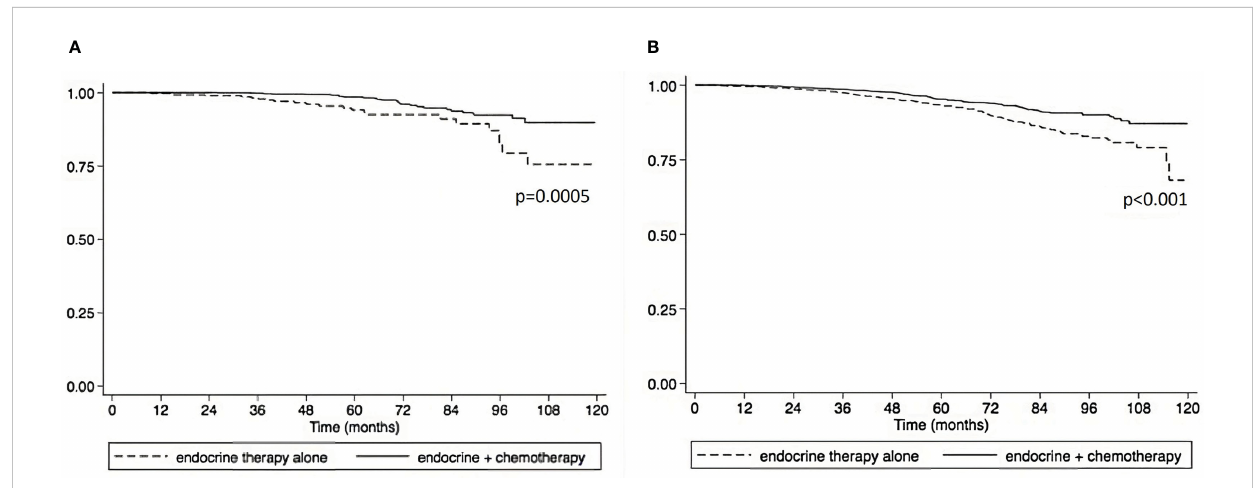
FIGURE 3 Overall survival compared between endocrine therapy alone versus endocrine therapy plus chemotherapy in pathological stage I-III HR+HER2- breast cancer patients with 1 – 3 positive nodes and RS 20-25. (A) premenopausal patients. (B) postmenopausal